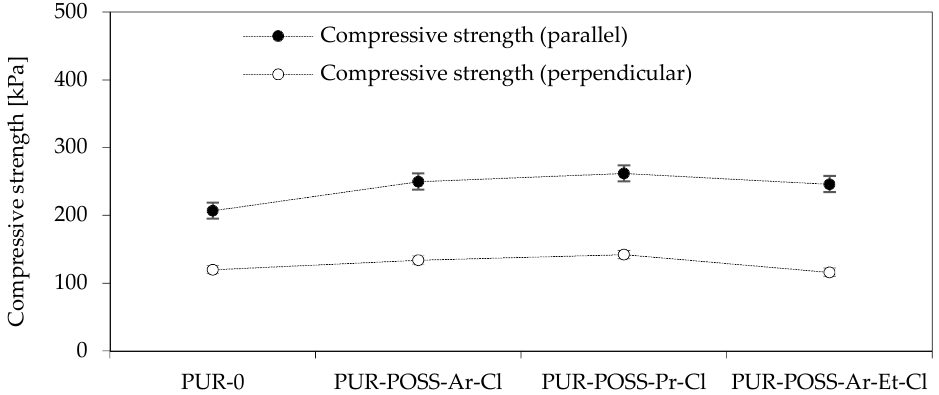
Figure 3. Compressive strength in the direction parallel and perpendicular to the growth direction of PUR of PUR foams.